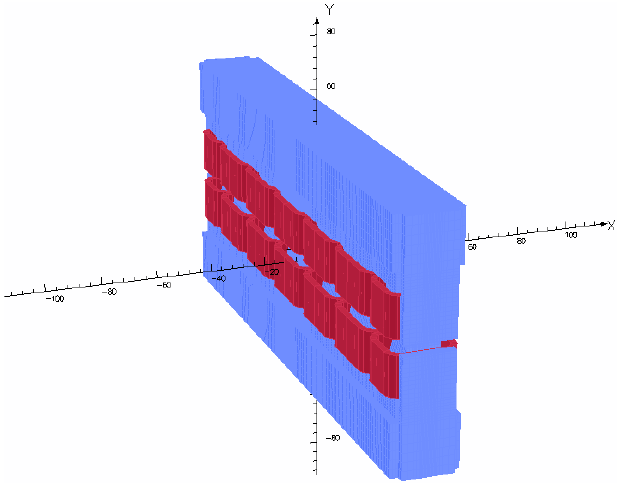
FIG. 6. (Color) 3D model of the complete wiggler of DA (cid:1) NE without any shaping of the poles. For the symmetry of the wiggler only 1 = 8 of the entire magnet has been simulated. Dimensions are in cm.